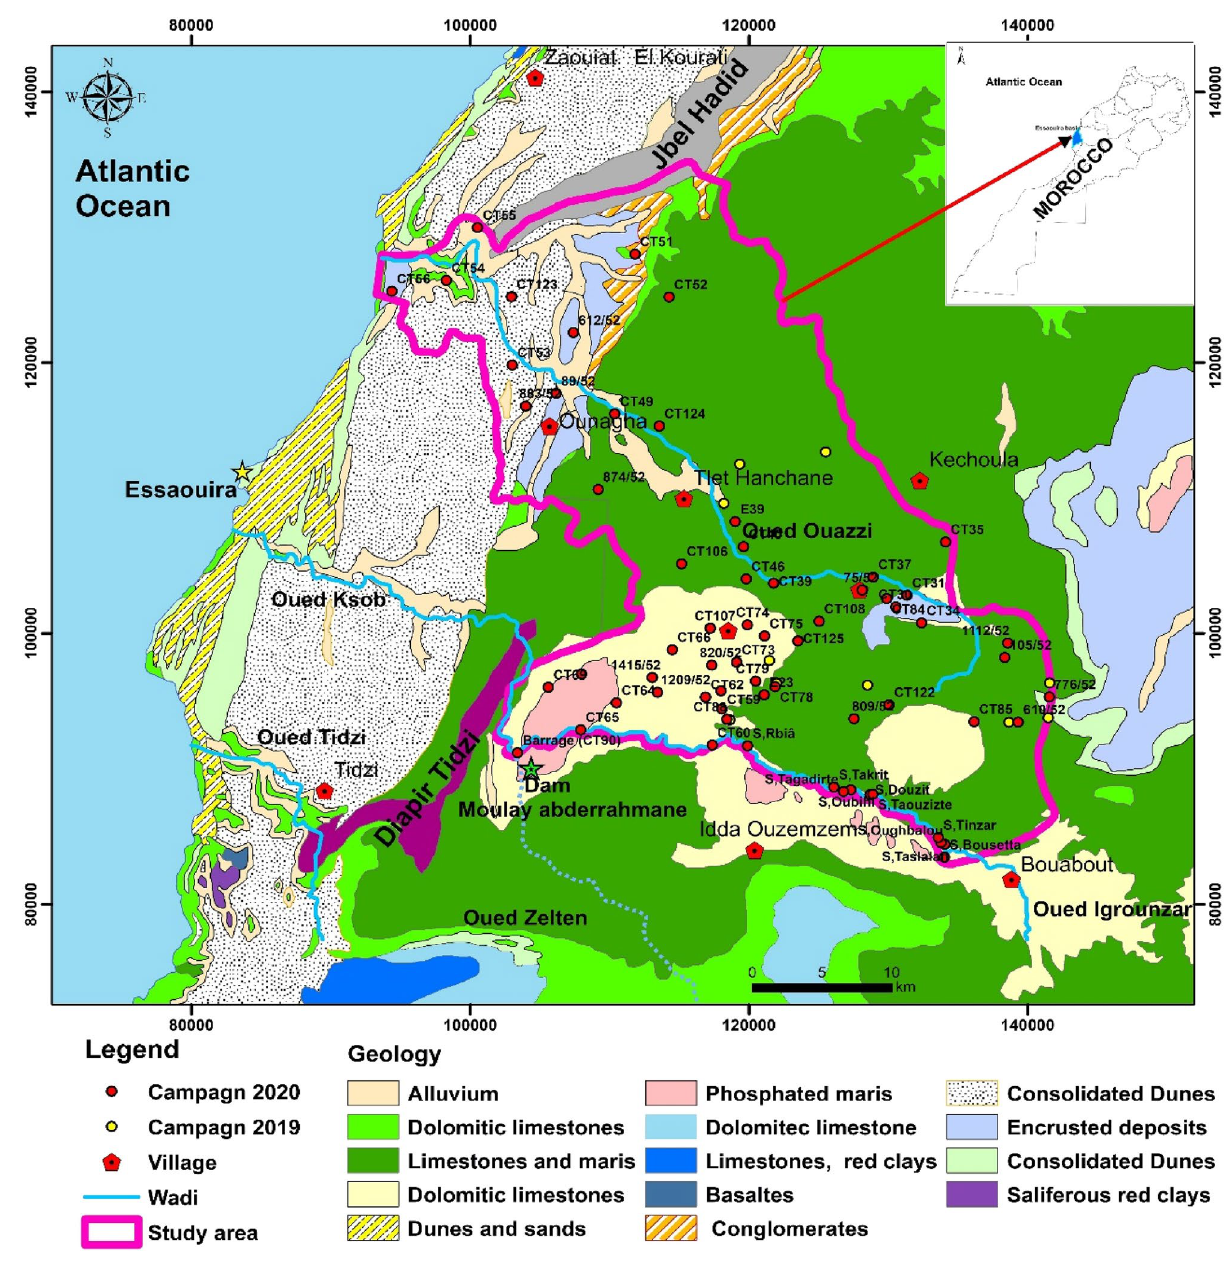
Fig. 1 Map of the study area, showing sampling locations and